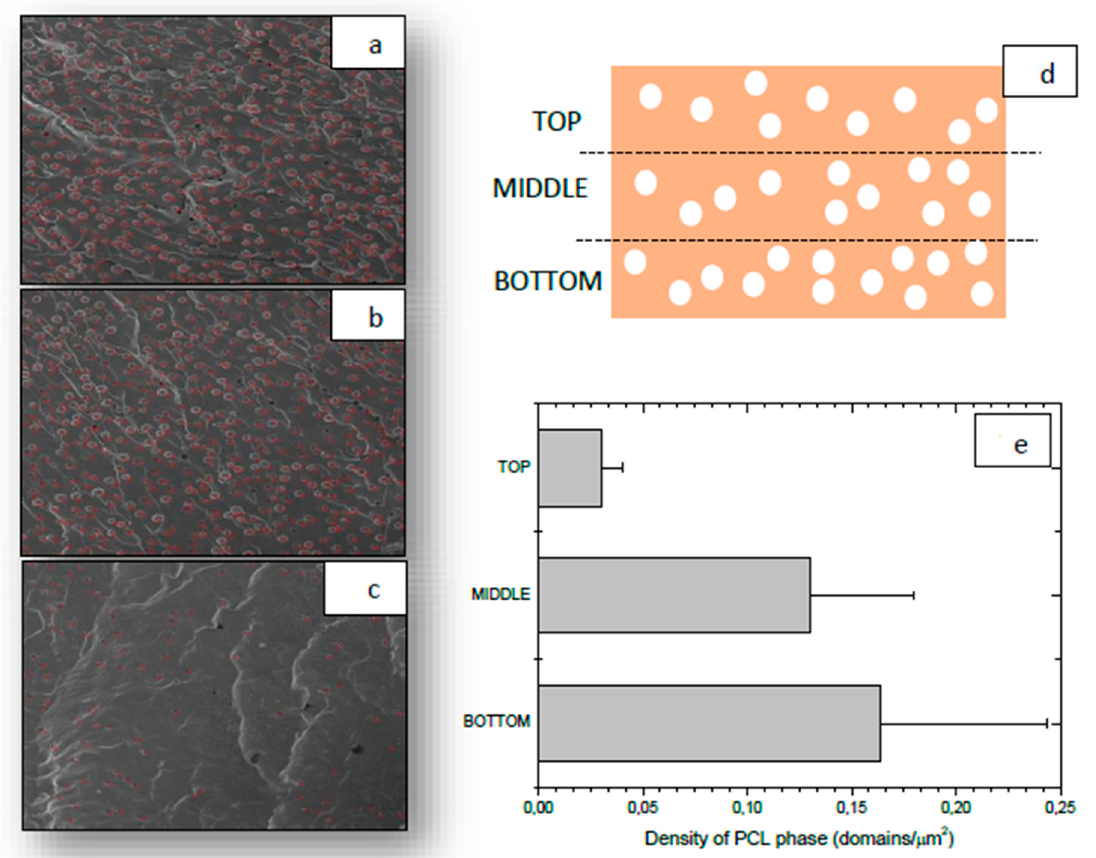
Figure 3. Analysis of PCL distribution for the PCL/DGEBA/TETA blend with 25 wt % PCL: SEM images at different location on the sample: top ( a ), middle ( b ), and bottom ( c ), scheme of studied areas ( d ) and density of separated PCL domains as a function of its location in the sample ( e ).